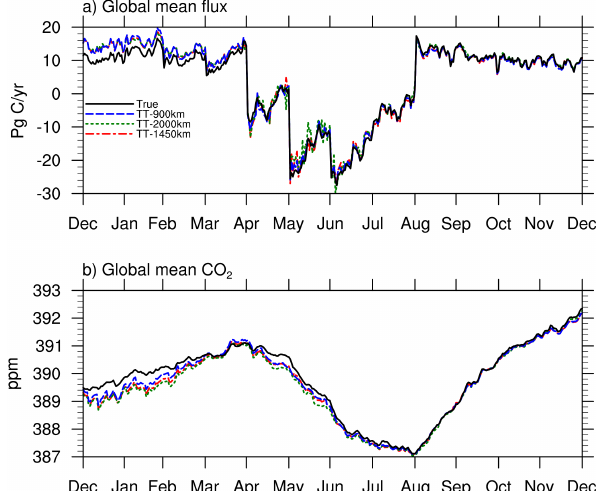
Figure 12. Time series of the daily global mean (a) CO 2 surface fluxes and (b) CO 2 concentrations from the “truth” and the TT (Tan- Tracker) assimilations using different covariance localization radii (900, 1450 and 2000km), respectively, from 1 January to 31 De- cember 2010.